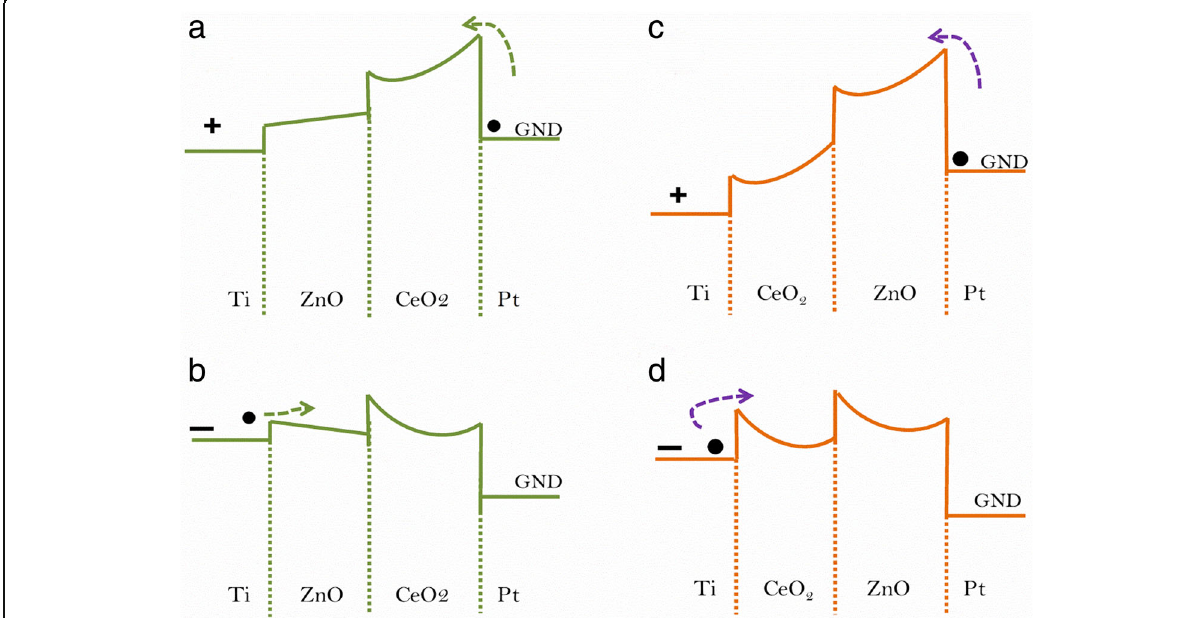
Fig. 8 Schematic diagrams for the conduction band offset of a , b Ti/ZnO/CeO 2 − x /Pt and c , d Ti/CeO 2 − x /ZnO/Pt heterostructure memory devices. Arrows represent electrons drift direction according to switching